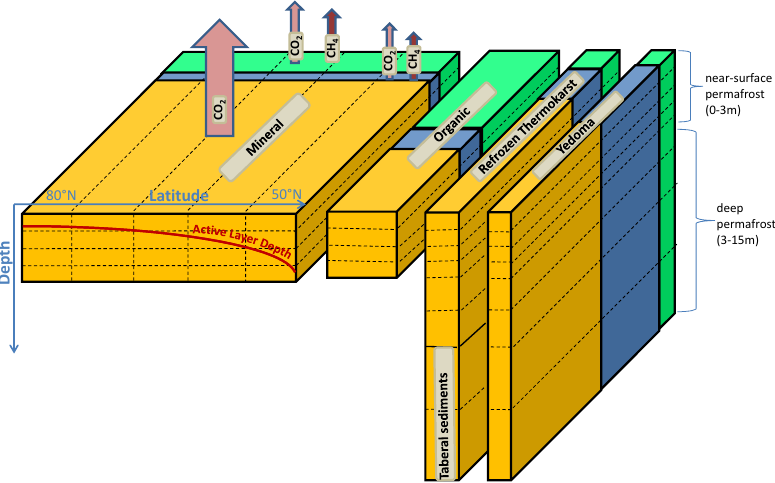
Figure 1. Schematic subdivision of permafrost soil carbon stocks into the four main pools (mineral soils, organic soils, refrozen thermokarst deposits (including taberal), and Yedoma deposits) and into aerobic (dark yellow) and anaerobic (blue: thermokarst lake, green: wetland) fractions. Individual boxes indicate the vertical extent and overall soil carbon quantity, as well as the aerobic and anaerobic fractions (not fully to scale). The dashed lines illustrate the model resolution into latitudinal bands (only shown for the mineral soil carbon pool) and vertical layers. Exemplarily, for the mineral soil carbon pool the north–south gradient of active layer depth (red line) and soil carbon release as CO 2 and CH 4 are also shown (broad arrows). Not shown is the additional differentiation into a fast and slow pool